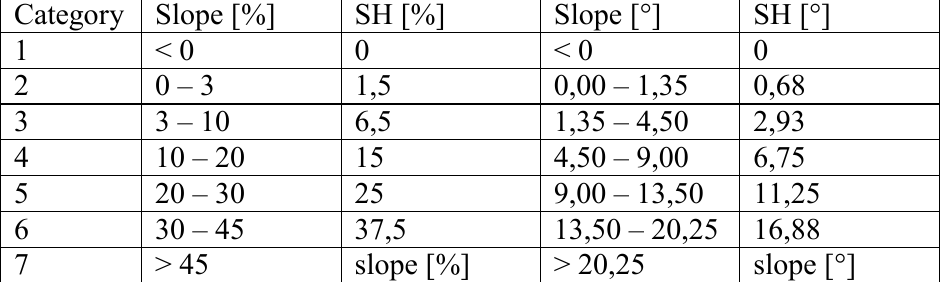
Table 1: Determination of mean value of the slope gradient (SH) from the measured range of slopes